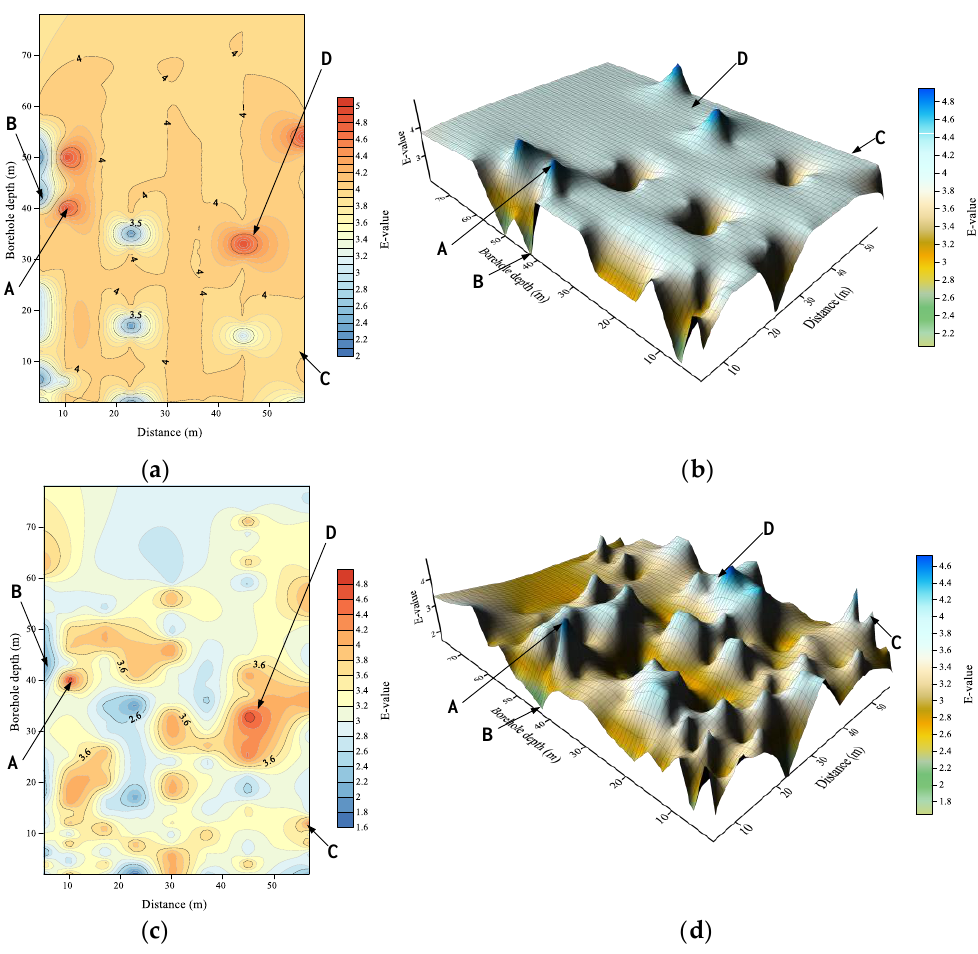
Figure 13. Grouting-efficiency assessment results based on the original evaluation methods: ( a ) Contour map of grouting efficiency based on single-indicator evaluation; ( b ) 3-D cloud map of grouting efficiency based on single-indicator evaluation; ( c ) contour map of grouting efficiency based on the method of Reference [26]; and ( d ) 3-D cloud map of grouting efficiency based on the method in Reference [26].